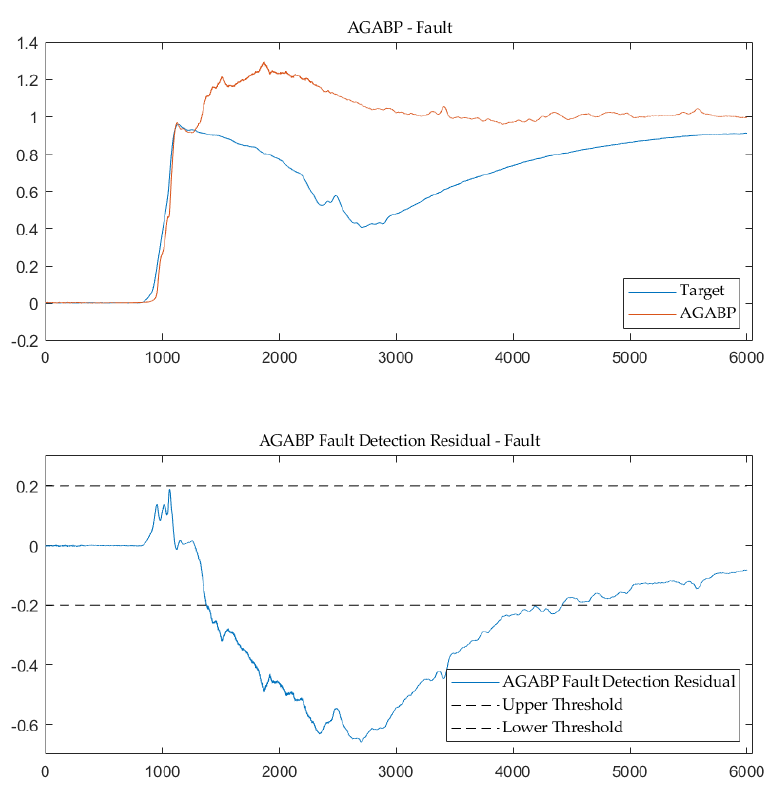
Figure 7. AGABP fault detection—fault.